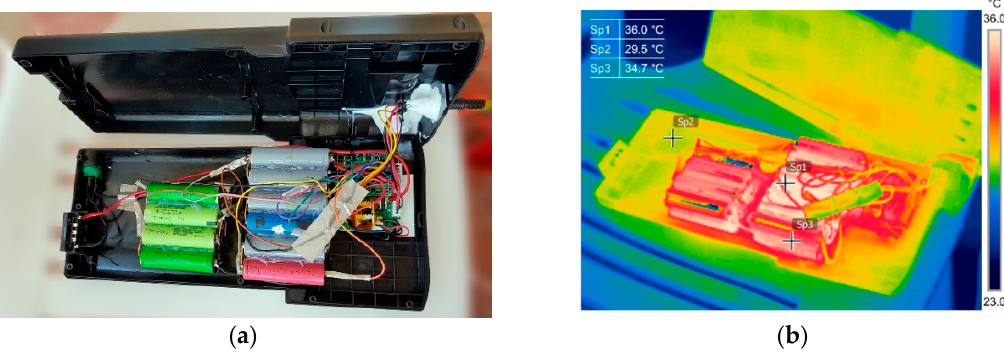
Figure 23. Repaired and revived battery pack: an assembly ( a ) and its thermal footprint ( b ). Table 6. Optimal layout of pack compound in 2p10s configuration restated from the used cells (considering its capacities, mAh).